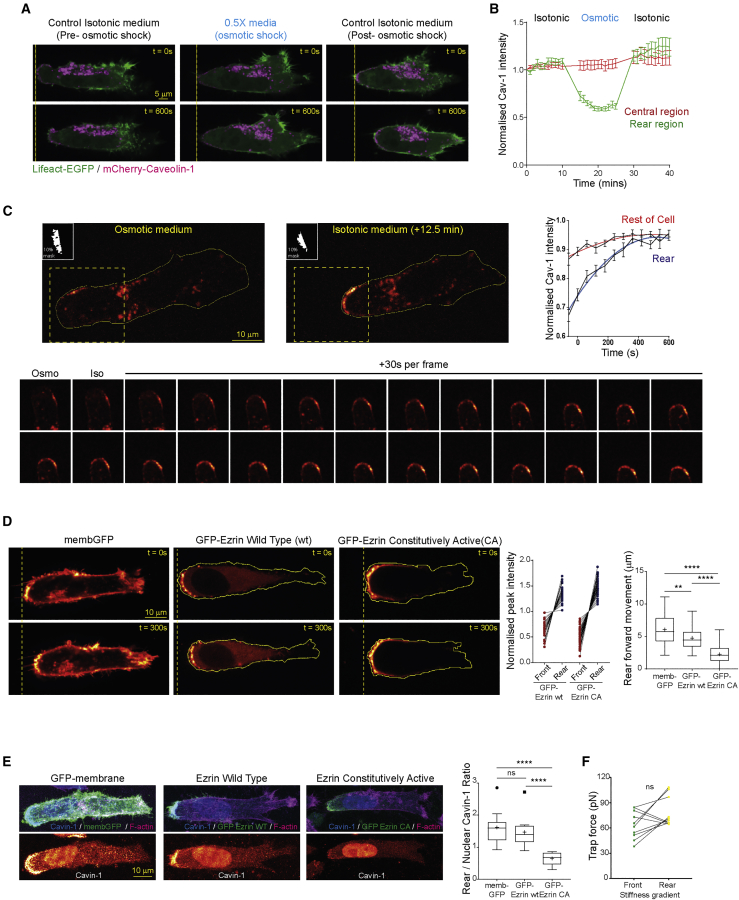
Increasing Membrane Tension Abrogates Rear Caveolae Formation and Forward Translocation(A) A2780 cell in 3D CDM imaged before and during hypo-osmotic shock and after recovery in isotonic media.(B) Rear mCherry-caveolin-1 intensity before and during osmotic shock, and after recovery in isotonic medium. N=12 cells, 3 repeats, bars = SEM.(C) Top left: cells as in (A) imaged every 30 s immediately after media change; top right: average normalized mCherry-caveolin-1 intensity in 10% rear mask (white inset in images) and rest of cell regions over time following osmotic to isotonic switch (N=17 cells, 3 repeats, bars = SEM, fitted quadratic curves showed in red and blue); bottom: montage of zoomed, 90° rotated rear region (highlighted by yellow box) imaged every 30 s post- osmotic-isotonic switch showing mCherry-caveolin-1 accumulation.(D) Left: A2780 cell in CDM expressing GFP-membrane (left), Ezrin wild type (WT, center) or Ezrin constitutively active (CA, right); center: pairwise normalized peak Ezrin intensity within front and rear regions (N>32 cells/condition, 3 repeats); right: average rear forward movement over 5 min (N > 39, 3 repeats).(E) Left: cells in CDM stained for F-actin (phalloidin) and caveolin-1, MIPs shown; center: rear/nuclear peak caveolin-1 intensity ratio (N>11 cells/condition, 3 repeats); right: paired trap force measurements at the front and rear of cells expressing CFP Ezrin-CA on durotactic gradients (N=10 cells, 3 repeats).∗∗p < 0.01; ∗∗∗∗p < 0.0001; ns, not significant. See also Figure S3 and Video S5.